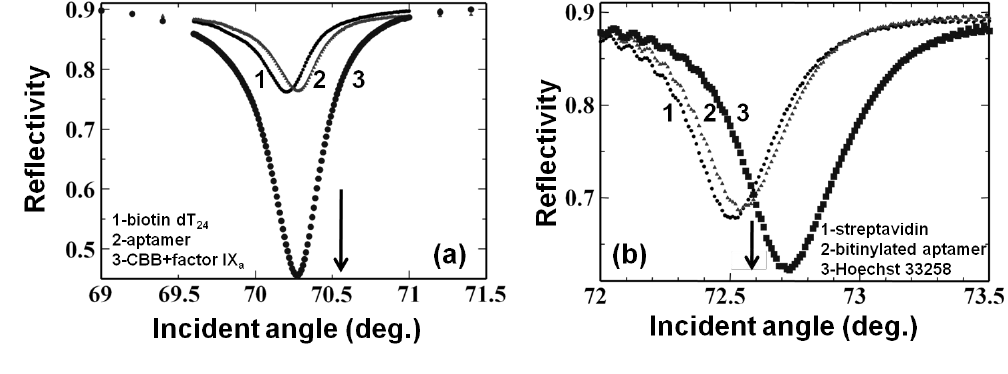
Figure 6. Effect of dye on spectral changes in waveguide-mode sensor. ( a ) CBB-based signal enhancement with aptamer and factor IXa [22]; ( b ) Interactions of DNA-aptamer and Hoechst dye